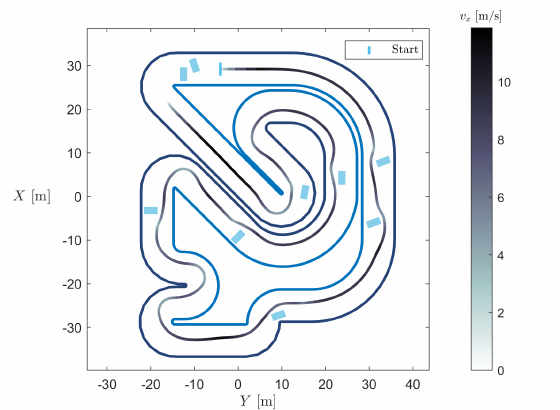
Figure 11. Described vehicle trajectory in a race track with